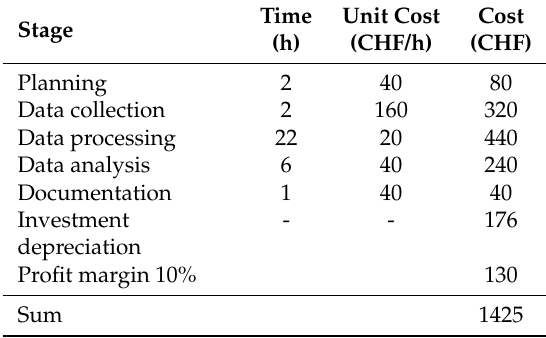
Table 8. UAS outsourced costs per flight.